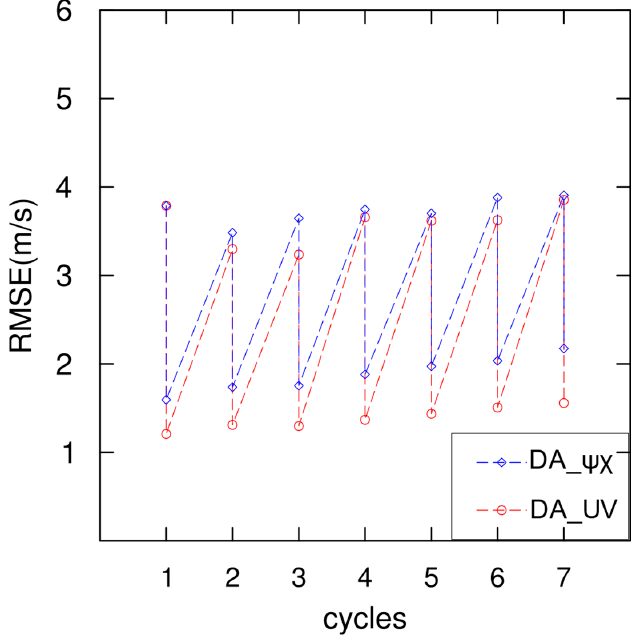
Figure 10. RMSEs of radial velocity (m s − 1 ) in DA_ ψχ and DA_UV of the background and analysis during data assimilation cycling.